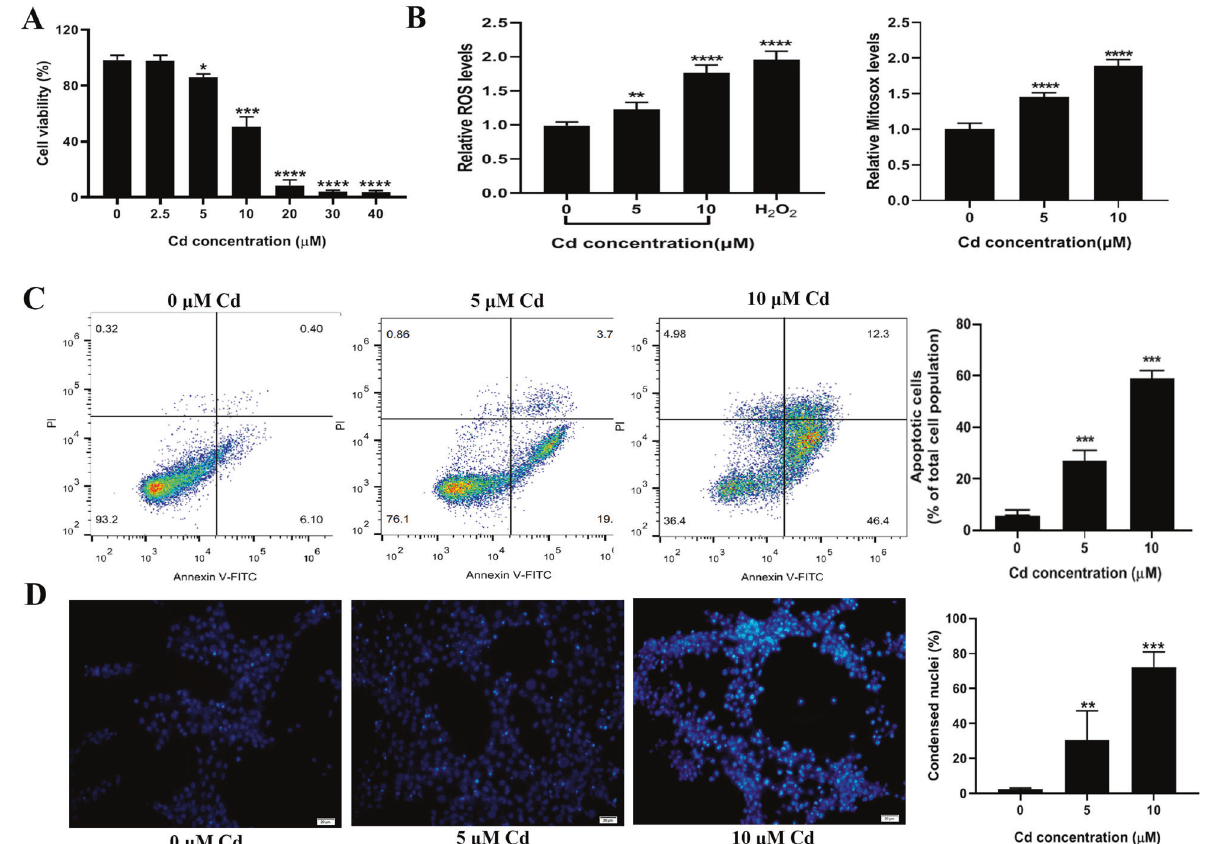
Fig. 3 Cadmium exposure decreased cell viability and induced ROS and apoptosis of TM3 cells. A TM3 cells were exposed to different concentrations of cadmium for 24 h. The cell viability was measured by CCK-8 assays. B Cellular ROS and Mitochondrial ROS production. C Apoptotic cells were detected by PI and Annexin V staining and represented as a percentage ratio. D Representative images of nuclear staining with Hoechst33342 in TM3 cells. Apoptotic cells were quantitated by nuclear condensation. Data represent the mean±SD for at